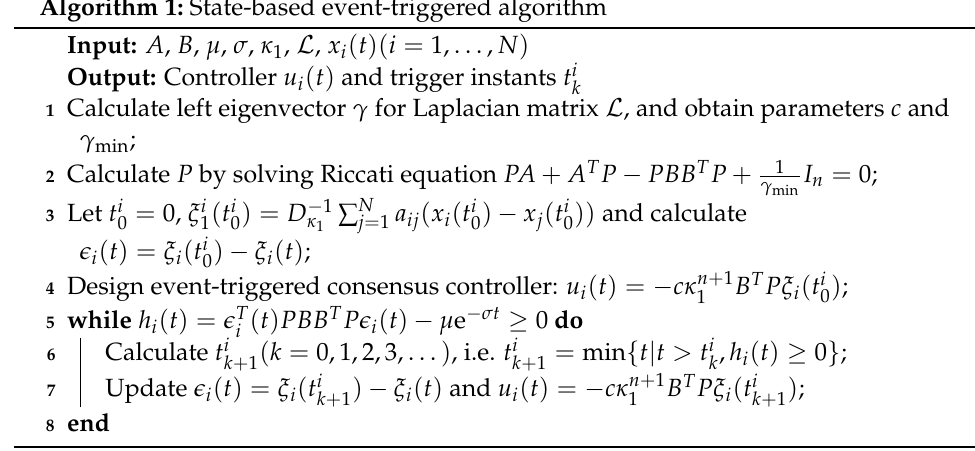
Algorithm 1: State-based event-triggered